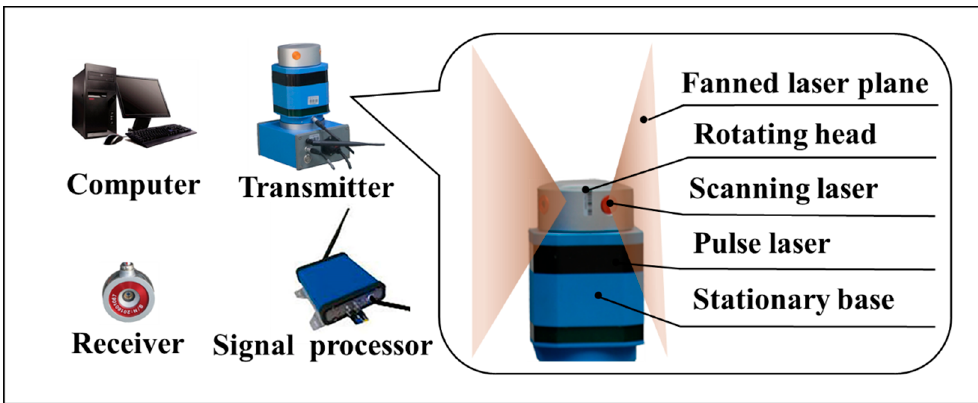
Figure 1. Structure of the workspace measuring and positioning system (wMPS). Figure 1 . Structure of the workspace measuring and positioning system (wMPS).